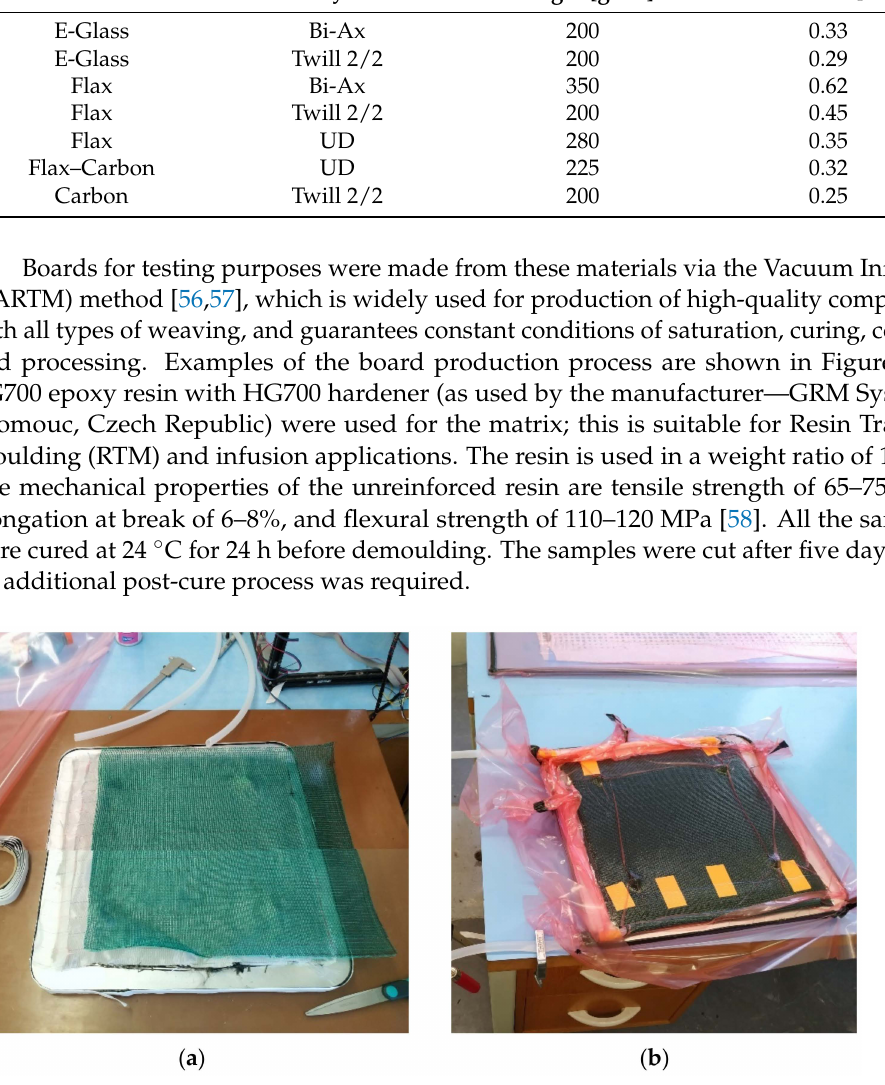
Figure 1. Vacuum infusion process: ( a ) prepared auxiliary materials; ( b ) product during